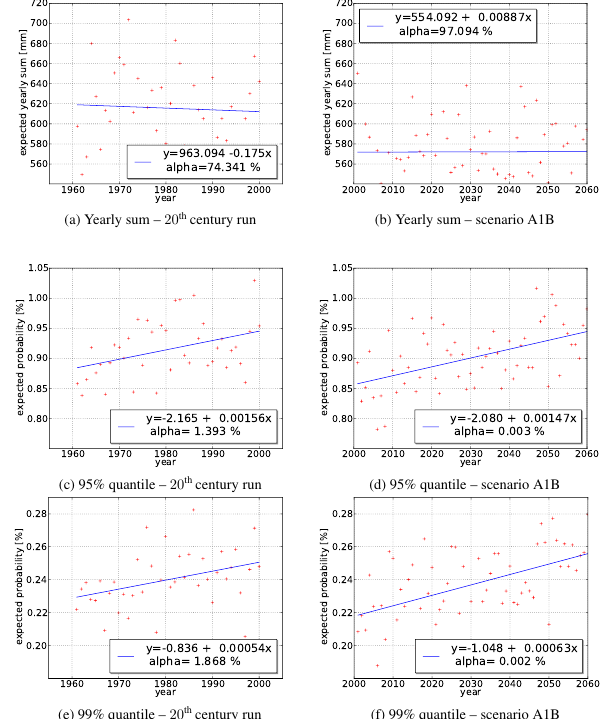
Fig. 11. Linear trend in the expected yearly precipitation sum and the yearly probability of values exceeding the 95% and 99% quantile according to the CP-temperature sequence derived from ECHAM5; quantiles refer to the calibration period from 1991 to